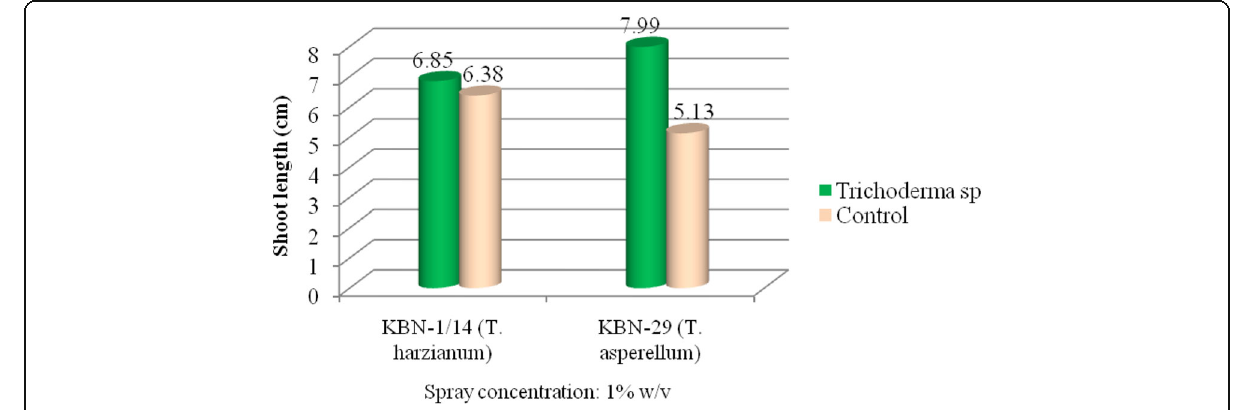
Fig. 4 Vegetative growth promotional effect of Trichoderma spp. on DS tea (2 MAS)